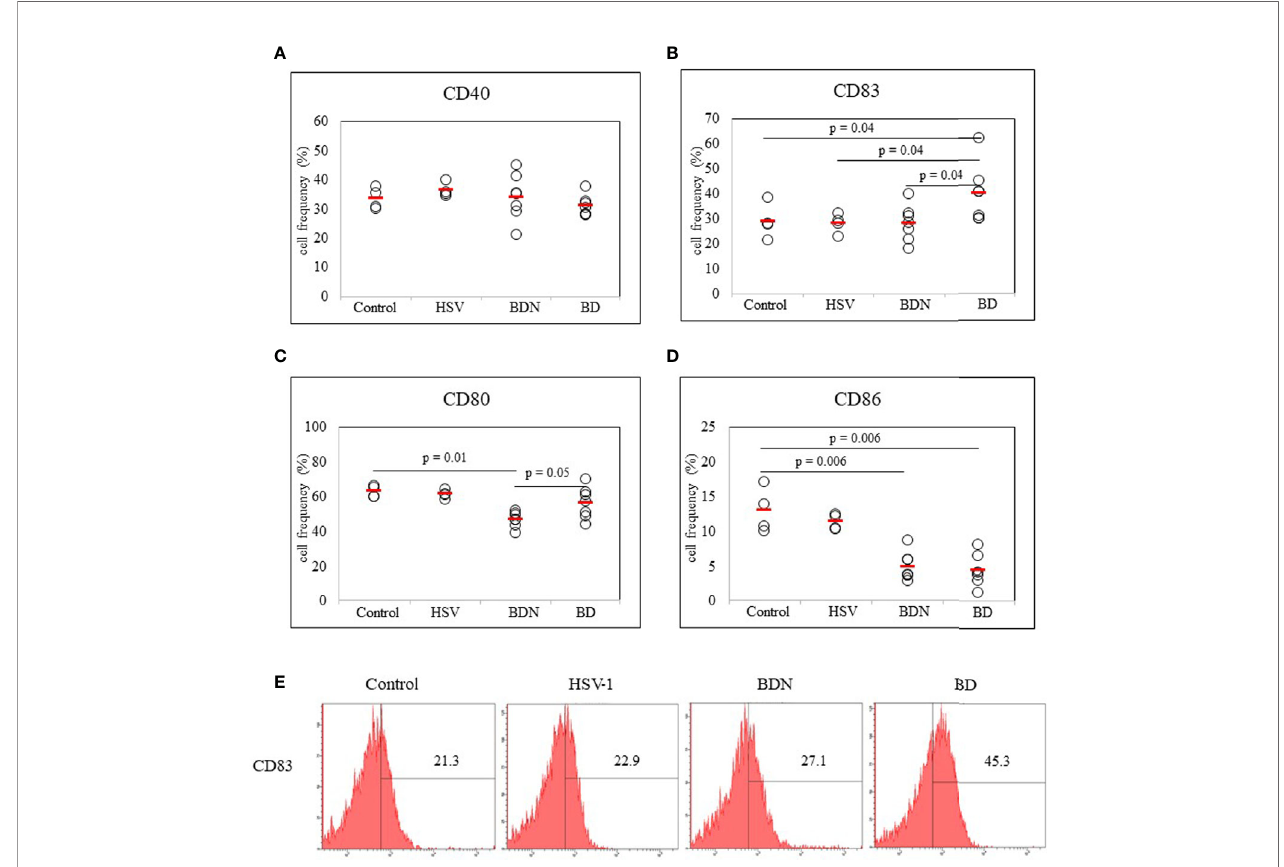
FIGURE 2 | Frequencies of DC costimulatory molecules CD40, CD83, CD80, and CD86 in peripheral blood leukocytes (PBLs) were evaluated in normal, HSV-1 inoculated, BDN, and BD mice. Isolated PBLs were analyzed by fl ow cytometry after surface staining (A – D) . Representative histogram of CD83+ cells is shown in (E) . For statistical analysis, the Mann-Whitney U test was performed with GraphPad. Experiments were performed independently at least three